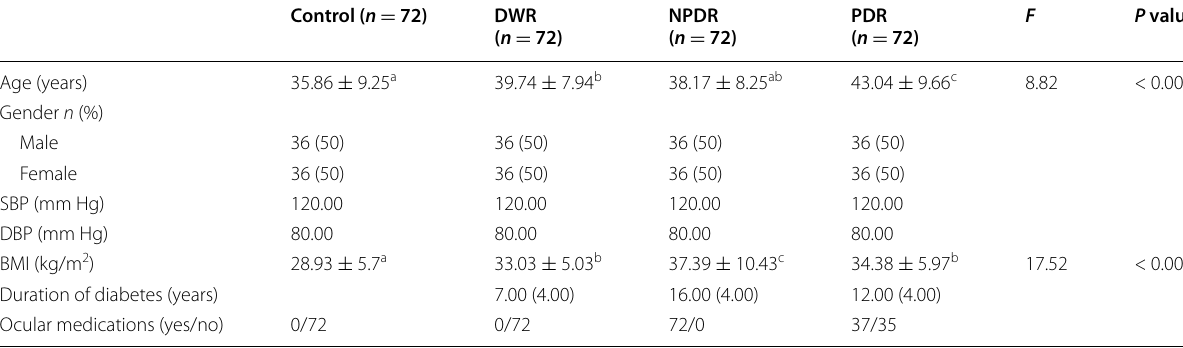
Data are expressed as mean SD for parametric variables and frequencies (percentages) for categorical variables ± DWR diabetes without retinopathy, PDR proliferative diabetic retinopathy, NPDR non-proliferative retinopathy, SBG systolic blood pressure, DBP diastolic blood pressure, BMI body mass index Different characters denote significance at p < 0.0001 The mean difference is significant at p <